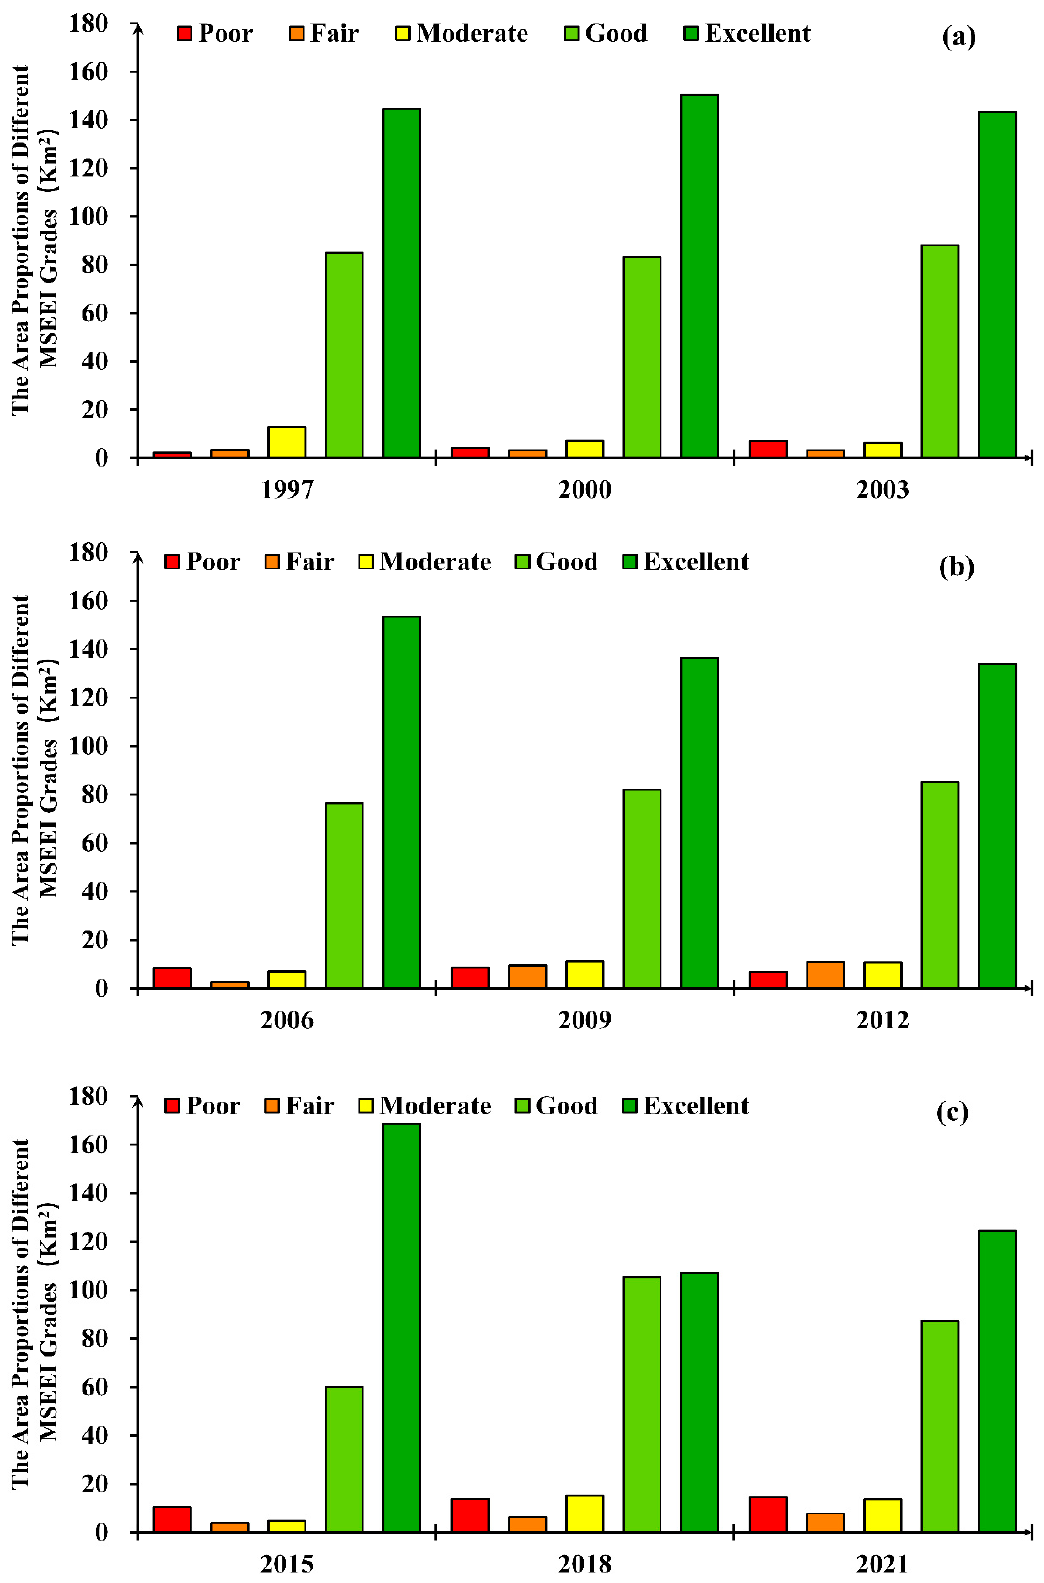
Figure 7. Areas of the ecological statuses of mining areas in 1997, 2000, 2003 ( a ); areas of ecological status of mining areas in 2006, 2009, 2012 ( b ); areas of ecological status of mining areas in 2015, 2018, 2021 ( c ).